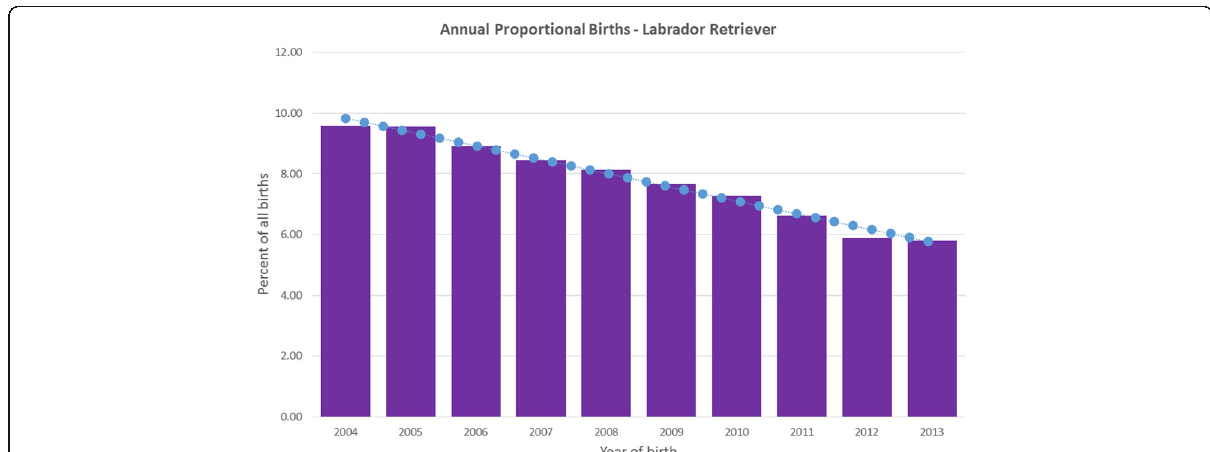
Fig. 1 Annual proportional birth rates (2004 – 2013) for Labrador retrievers ( n = 33,320) among all dogs ( n = 455,557) attending UK